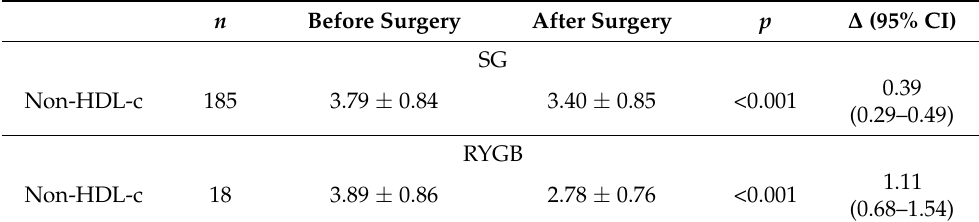
Table 1. Non-high-density lipoprotein cholesterol before and 12 months after bariatric surgery. n Before Surgery After